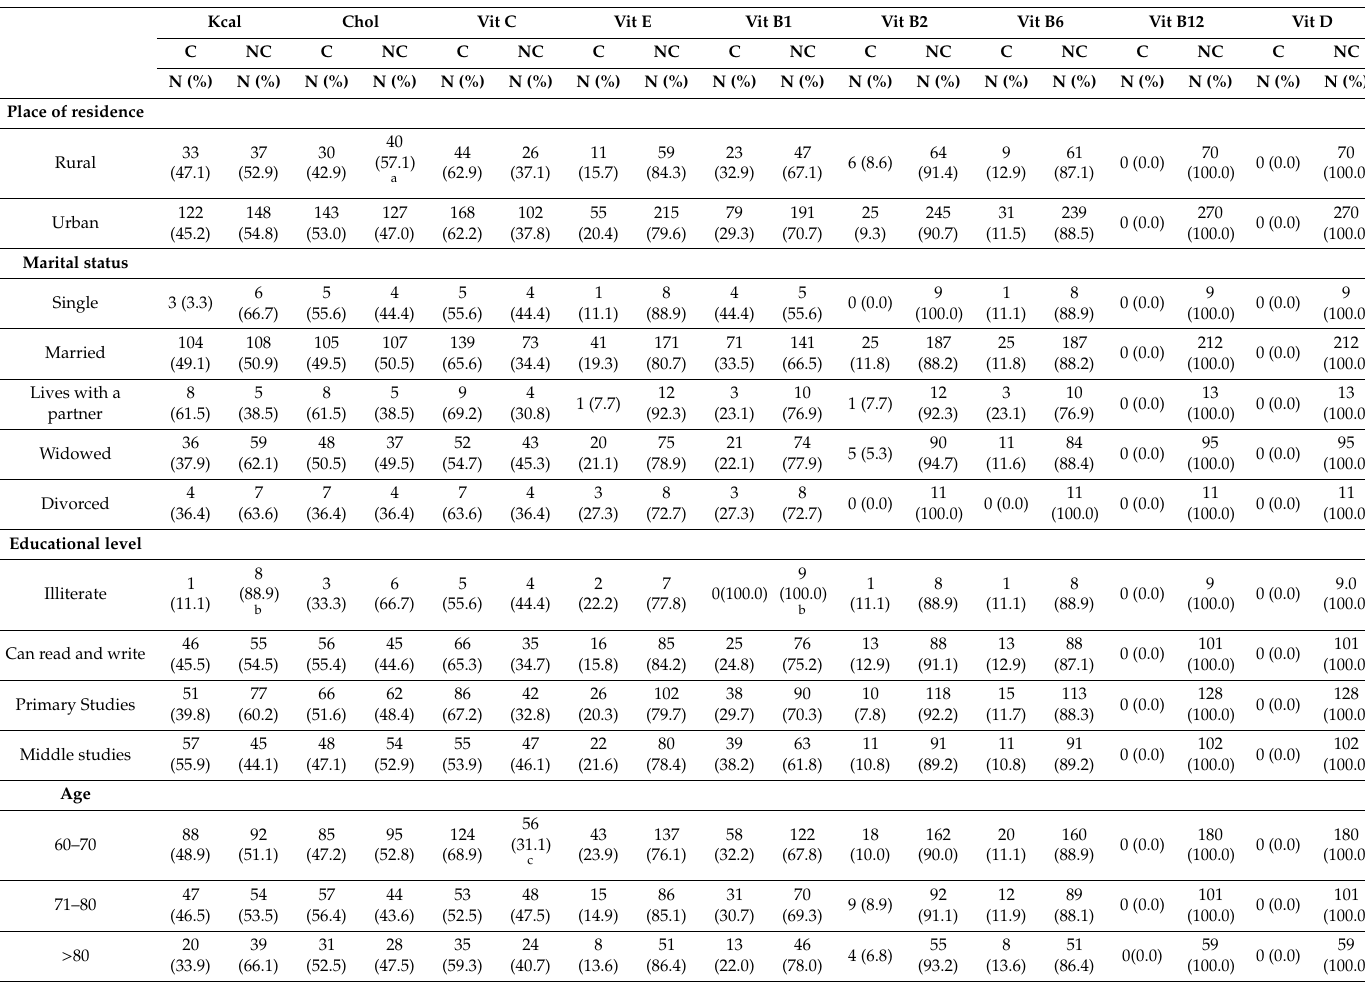
Table 4. Relationship between sociodemographic variables and compliance with daily intake recommendations for vitamins, energy, and